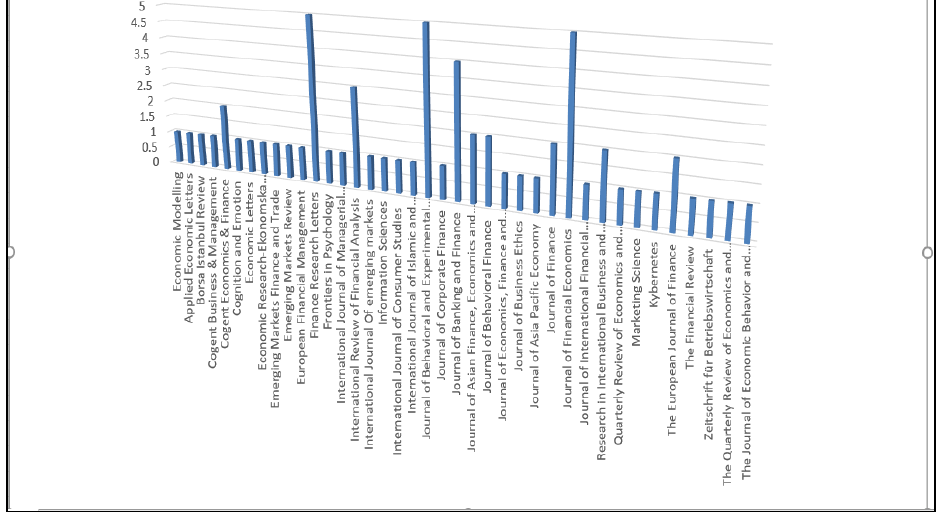
Figure.3.Research Journals